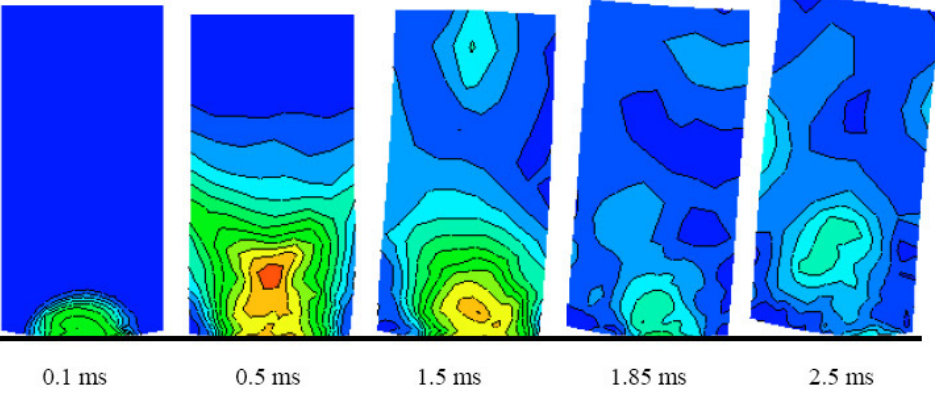
Fig. 2. Evolution of von Mises stress versus time.